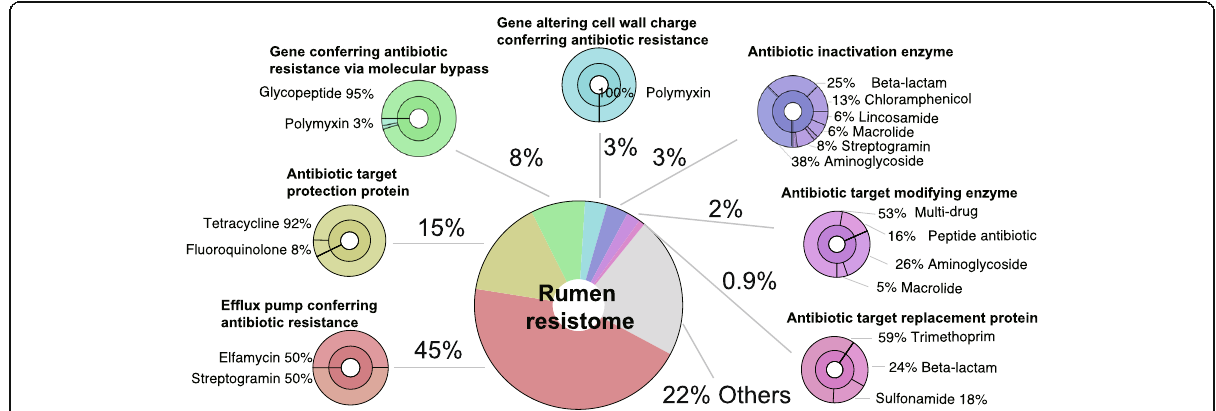
Fig. 2 Antimicrobial resistance mechanisms in the rumen microbiome. The rumen microbiome in dairy cows exhibited broad antimicrobial resistance mechanisms classified in 7 categories. The classes of antimicrobials observed in the category of each mechanism are